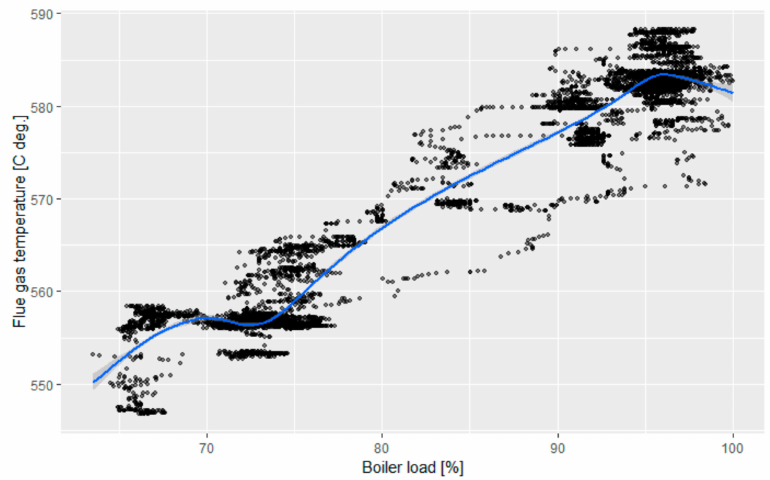
Figure 2. Correlation between flue gas temperature and the load level of pulverized-coal boiler with 120 kg / s nominal steam capacity (own